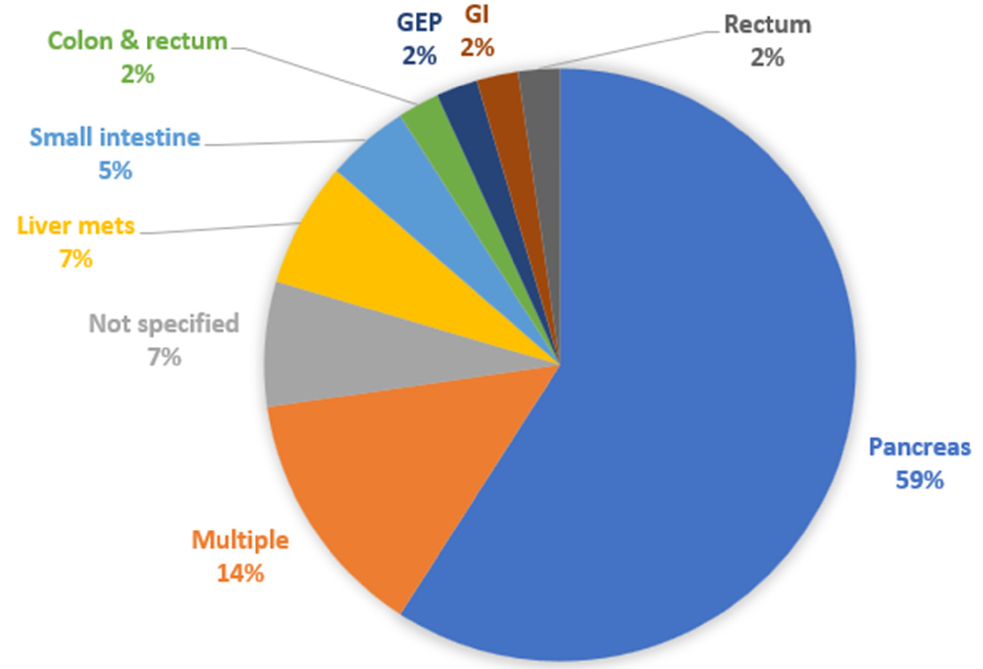
Figure 4. Distribution of studies by type of NET analyzed. GEP: gastroenteropancreatic; GI: gastrointestinal.